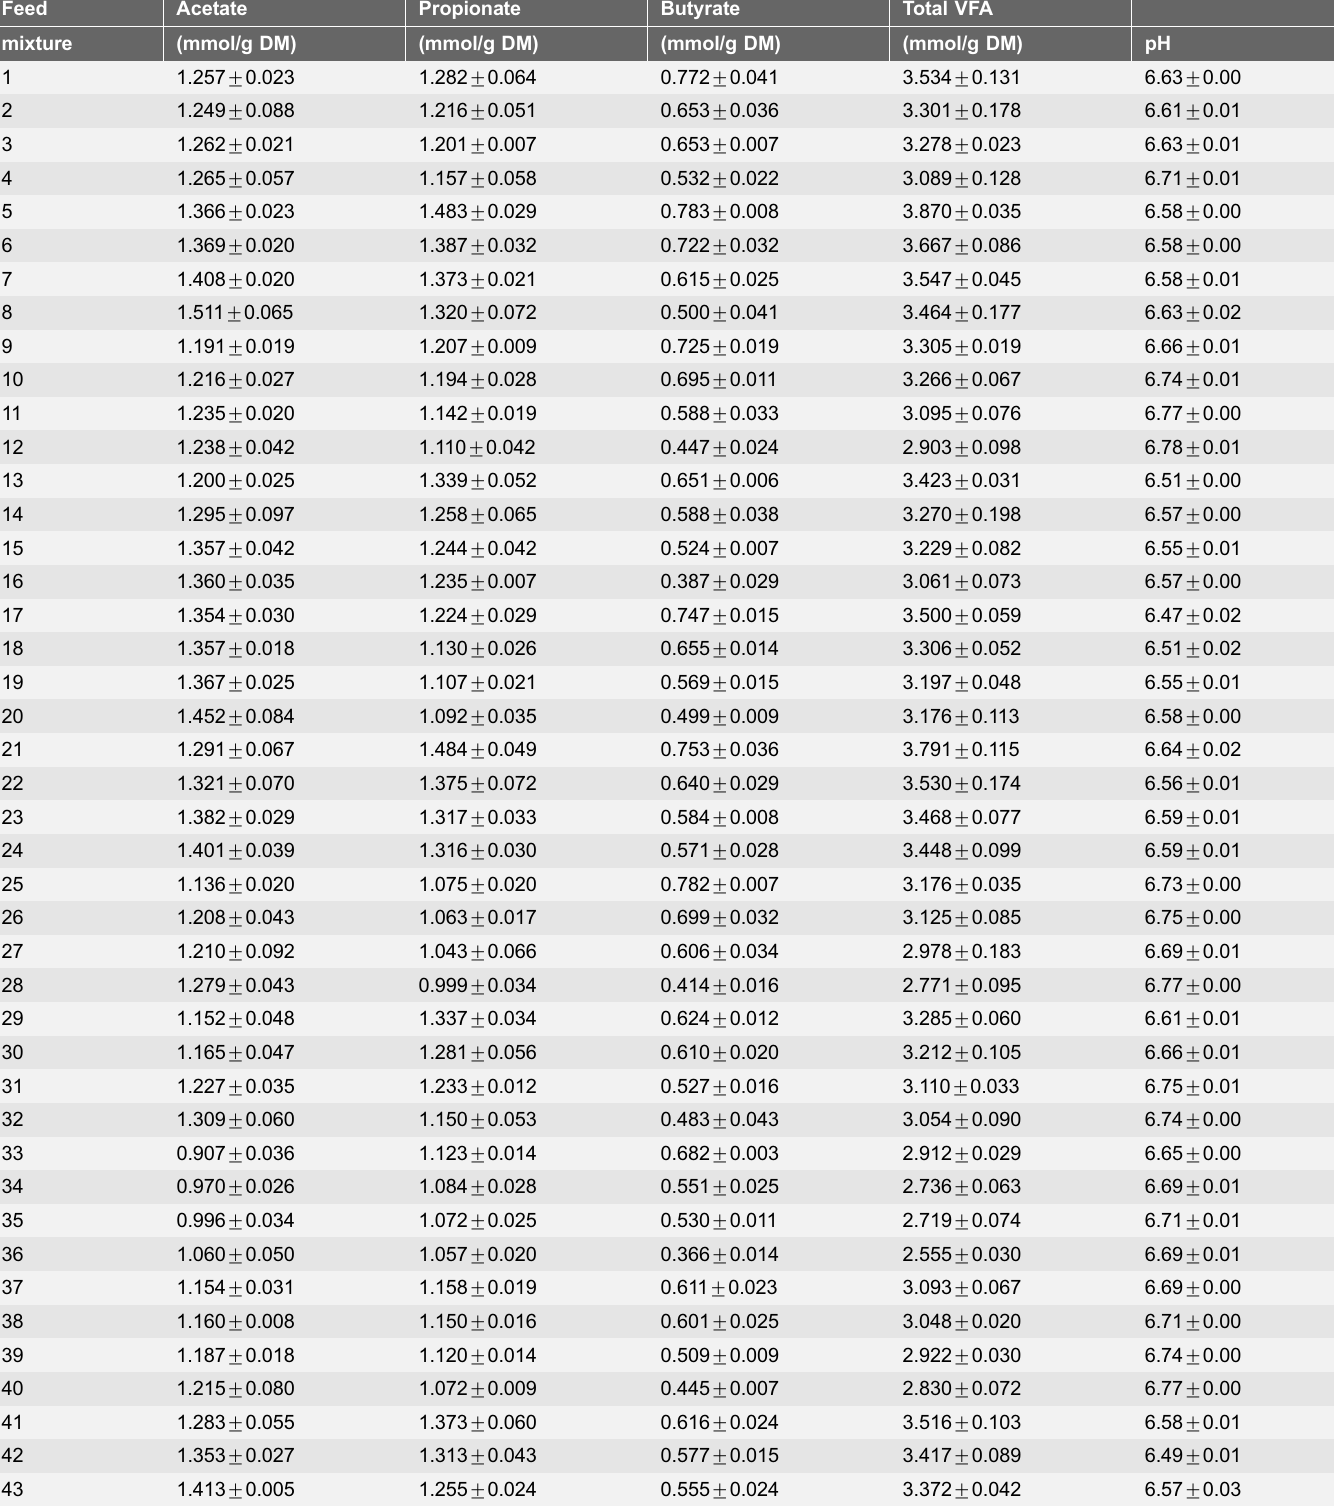
Table 5. The acetate, propionate, butyrate, and total VFA production and pH of feed mixtures for